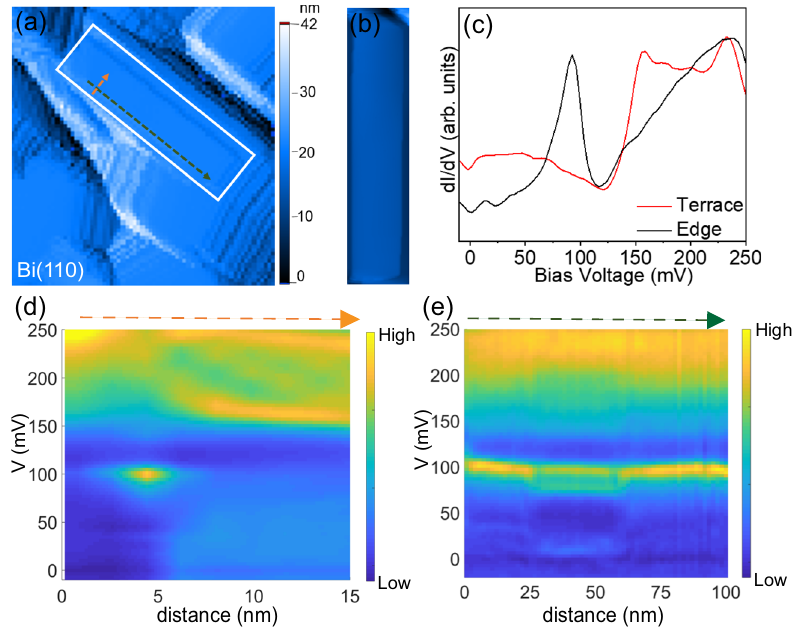
Fig. 2 Spectroscopic measurements along and across the edge of a rectangular facet of a Bi(110) island. a Large area (250 nm × 350 nm) image of a Bi (110) fi lm. The island of interest is marked by a white box. b Zoomed-in image of the Bi(110) island in ( a ). The color bar shows the relative height in the topography. c d I /d V spectra at the edge and center of the island (ac modulation 3.5 mV and current 100 pA). The edge spectrum shows a peak corresponding to the edge mode. d , e Intensity plot of STM spectra across (orange dashed line in ( a )) and along (green dashed line in ( a )) the step edge (ac modulation 3.5 mV and current 100 pA). The color bars indicate the relative height of the density of states.